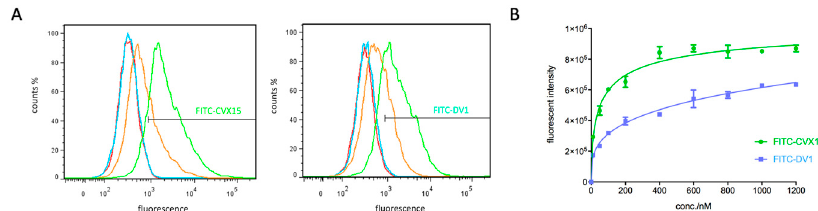
Figure 2. ( A ) FITC-CVX15 and FITC-DV1-labeled CHO-CXCR4 cell lines detected by FCM respectively. Red, blue, orange and green signals represent concentrations of 1 nM, 10 nM, 100 nM and 1000 nM respectively. ( B ) Saturation curves for binding of FITC-CVX15 and FITC-DV1 to CXCR4. Mean ± standard deviation; n = 3 independent experiments.